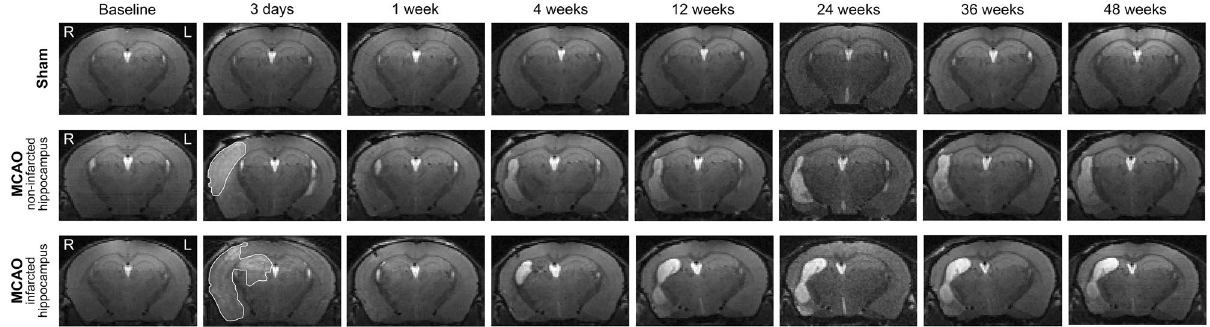
Figure 3. Representative T 2 -weighted images of a sham-operated mouse, an MCAO-operated mouse with a non-infarcted hippocampus, and an MCAO-operated mouse with an infarcted hippocampus. R (right) is the ipsilateral hemisphere and L (left) is the contralateral hemisphere, and all images have the same orientation. The hyperintense region in the ipsilateral hemisphere at 3-days post-stroke (area outlined in white) is the infarcted